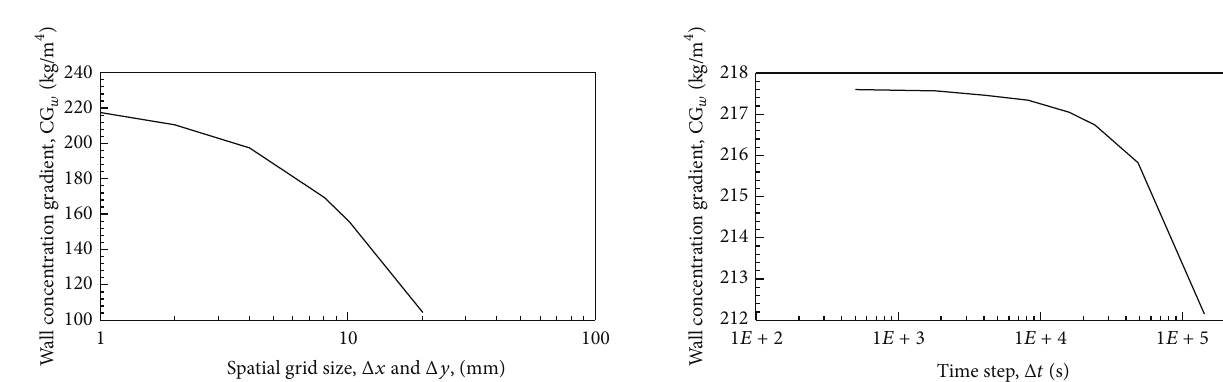
Figure 3: Effect of the time step size, Δ𝑡 , on the gradient of the chloride concentration at the left boundary, 𝑥 = 0 , for 𝑦 = 0 m, 𝑡 = 1 year, and Δ𝑥 = Δ𝑦 = 1 mm.